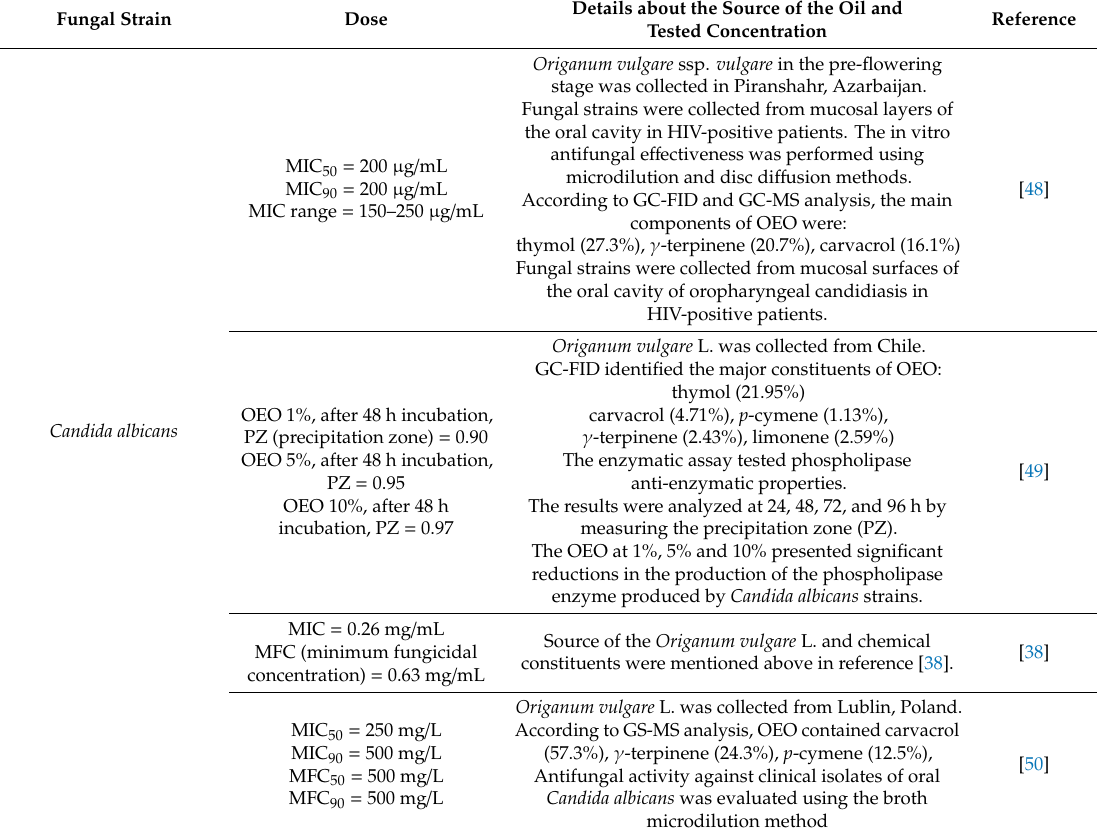
Table 3. Antifungal activity of Origanum vulgare L. essential oil